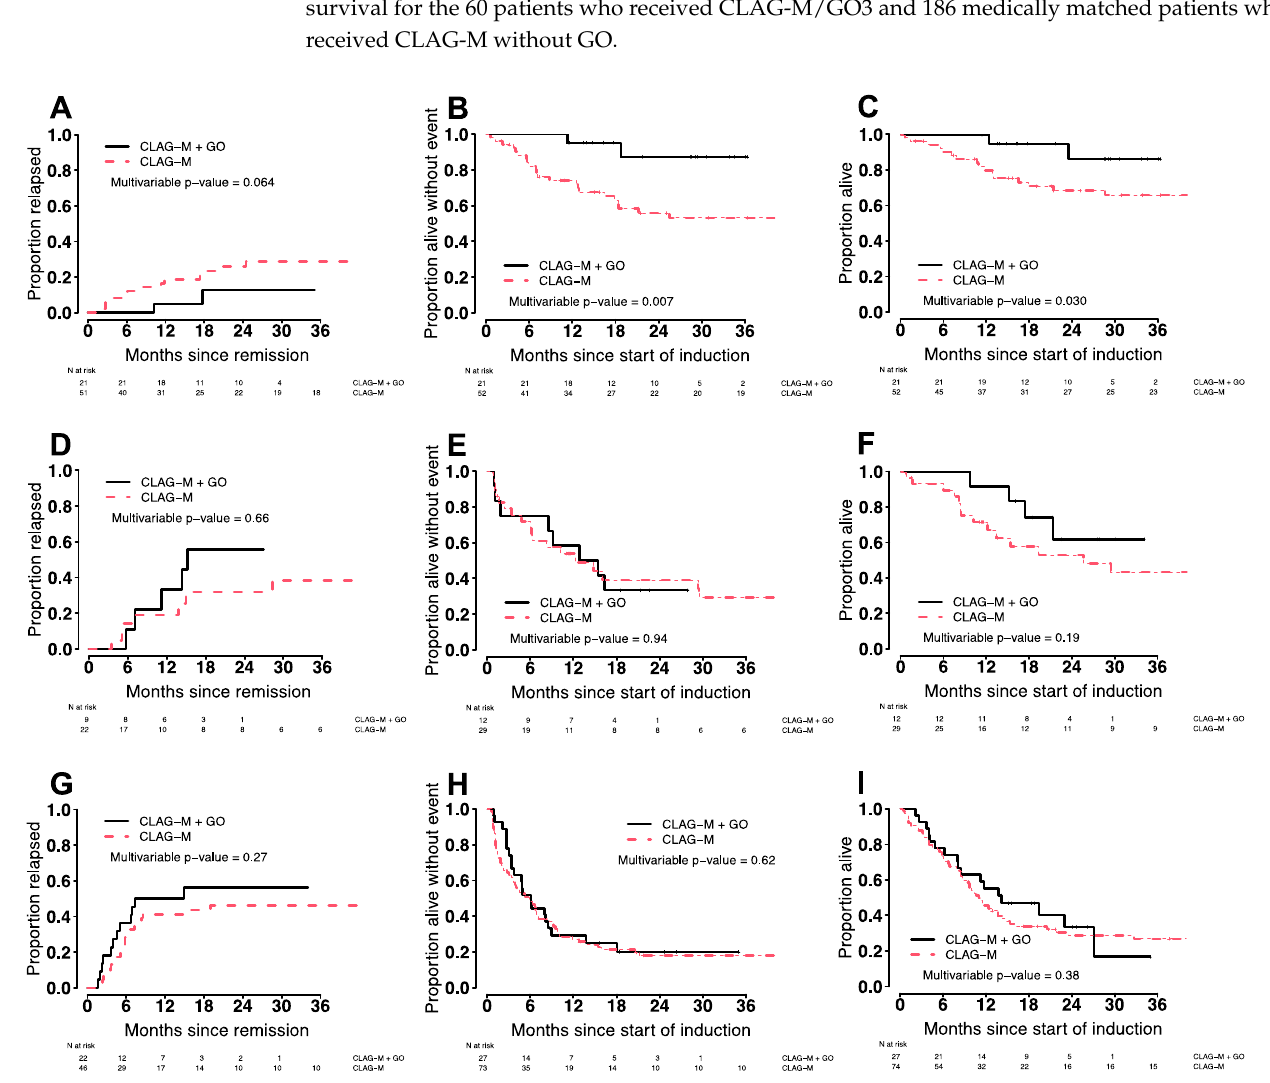
Figure 3. Estimates of ( A , D , G ) cumulative incidence of relapse, ( B , E , H ) event-free survival, and ( C , F , I ) overall survival for the 60 patients who received CLAG-M/GO3 and medically matched patients who received CLAG-M without GO, stratified by favorable ( A – C ), intermediate ( D – F ), and adverse ( G – I ) cytogenetic/molecular disease risk (ELN 2017 classification).